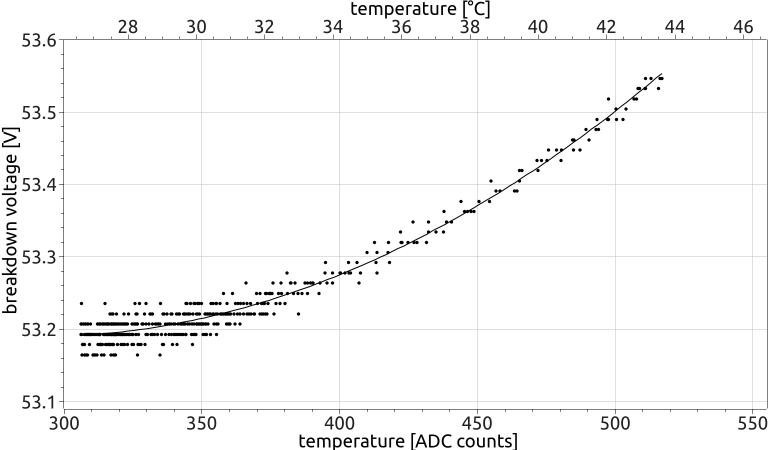
Figure 27. Dependence of the (cid:103) V BR breakdown voltage on the SiPM temperature measured by AFE. The calibration parameters of the AFE thermometer are taken from the vendor